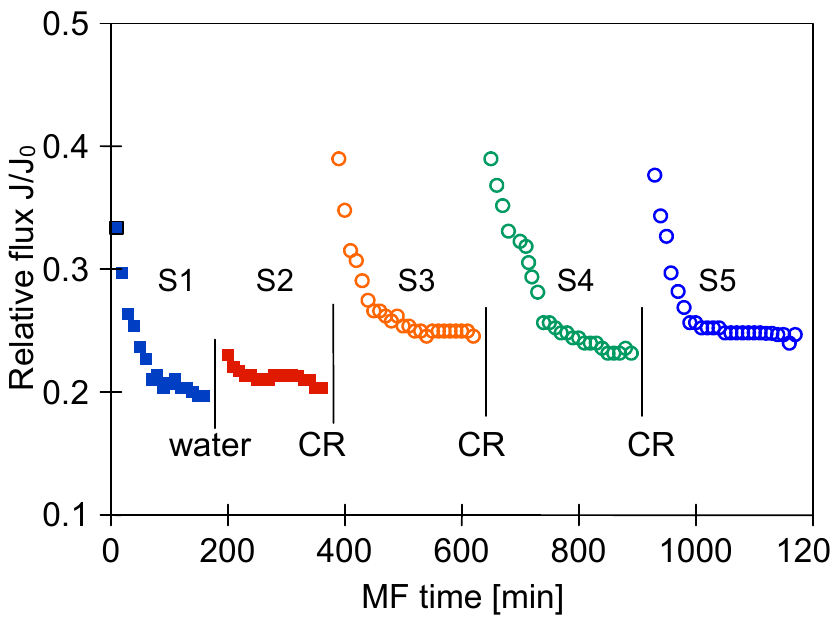
Figure 15. Changes in relative permeate flux during the long-term MF process of 1,3-PD fermentation broth with Lactobacillus casei with periodically cleaning the module. Module M4, TMP = 0.08 MPa, V F = 5.5 m/s, CR—chemical cleaning.